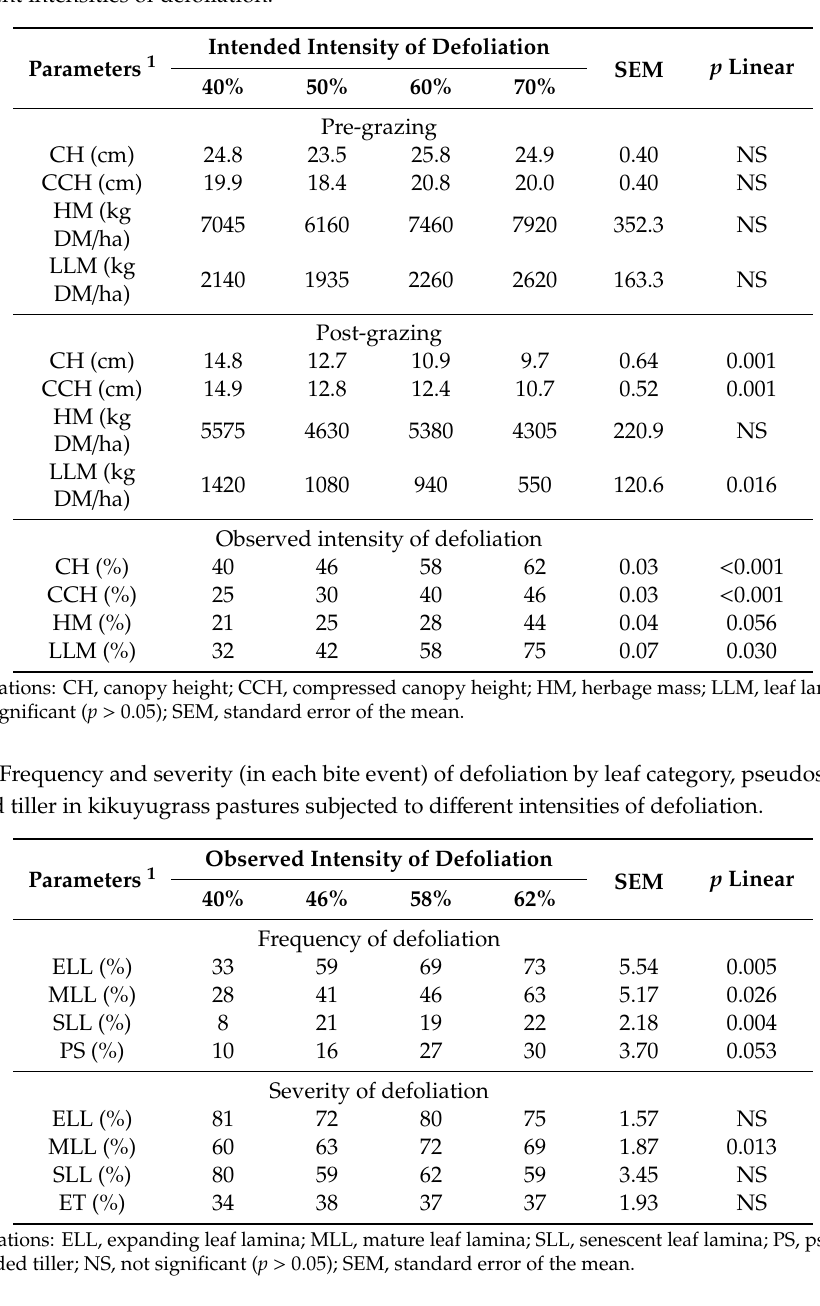
Table 1. Some average canopy characteristics at pre- and post-grazing in kikuyugrass pastures subjected to di ff erent intensities of defoliation.